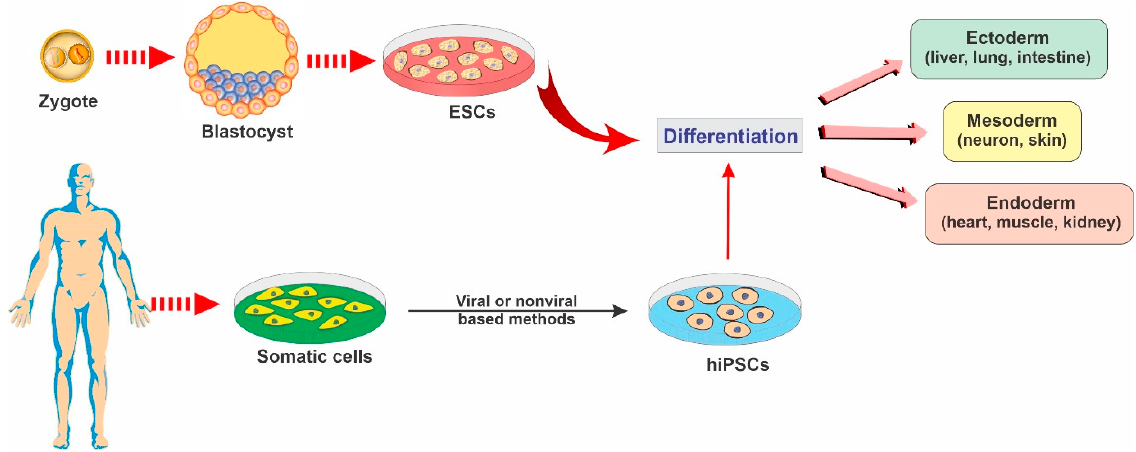
Figure 2. Representative diagram depicting the main types of stem cells and their potential to differentiate into various lineages.